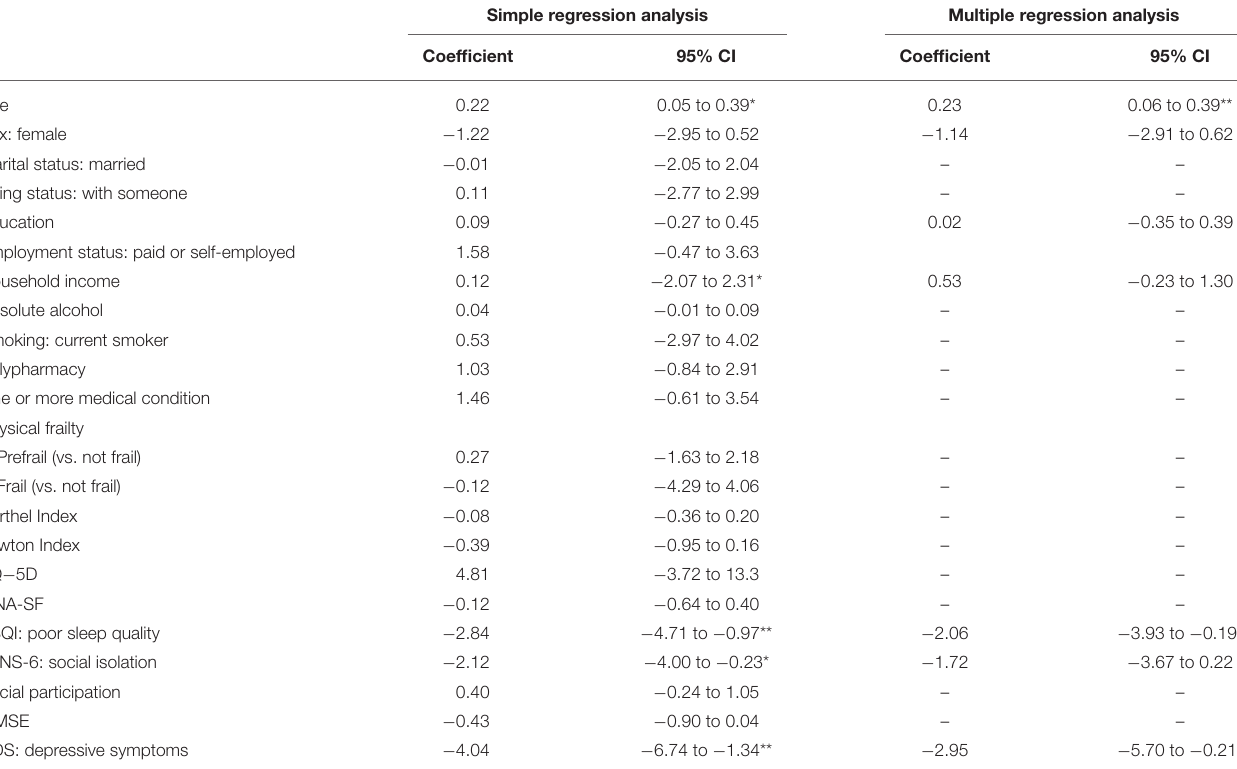
TABLE 2 | Simple and multiple regression analysis results for psychological resilience. Simple regression analysis Multiple regression